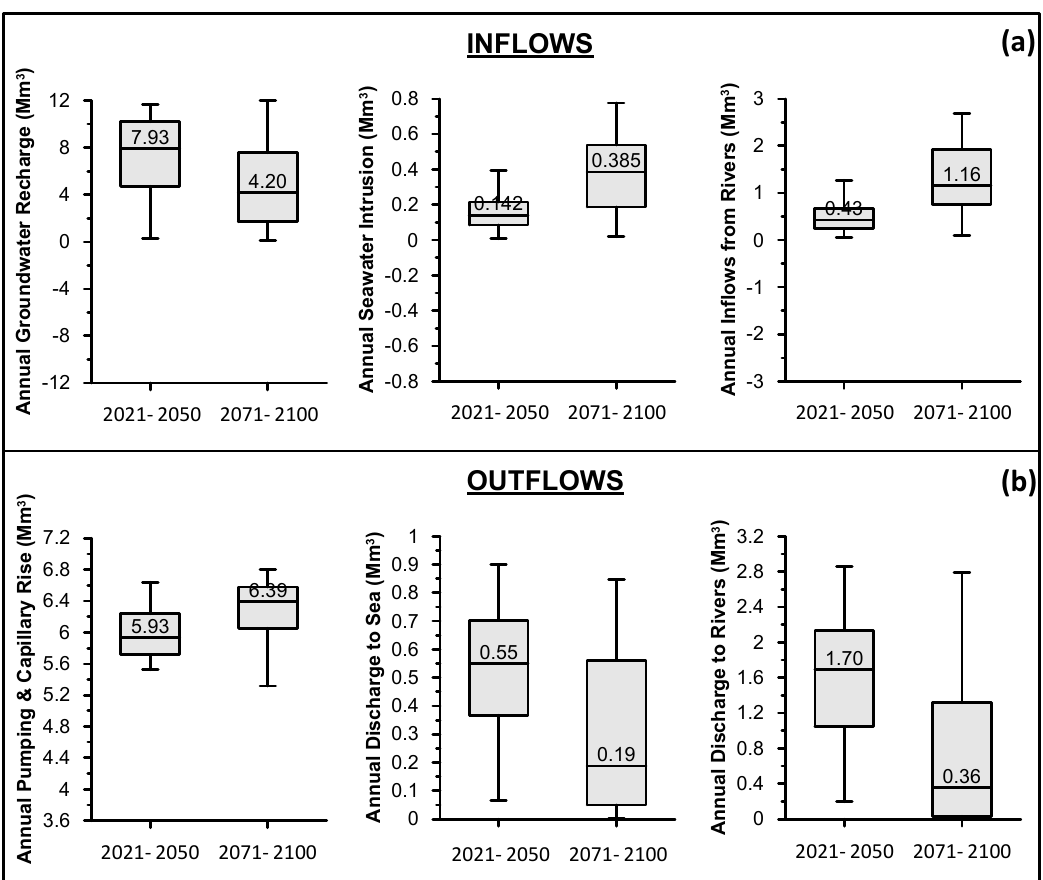
Figure 7. Boxplots presenting the annual variation of major: ( a ) inflows and ( b ) outflows for the two projected periods. The variation of aquifer budget outflows during the two projected periods are pre- sented in Figure 7b. Annual outflows in the form of groundwater abstraction and capillary rise for the satisfaction of irrigation demands were found to be on the median 5.9 Mm 3